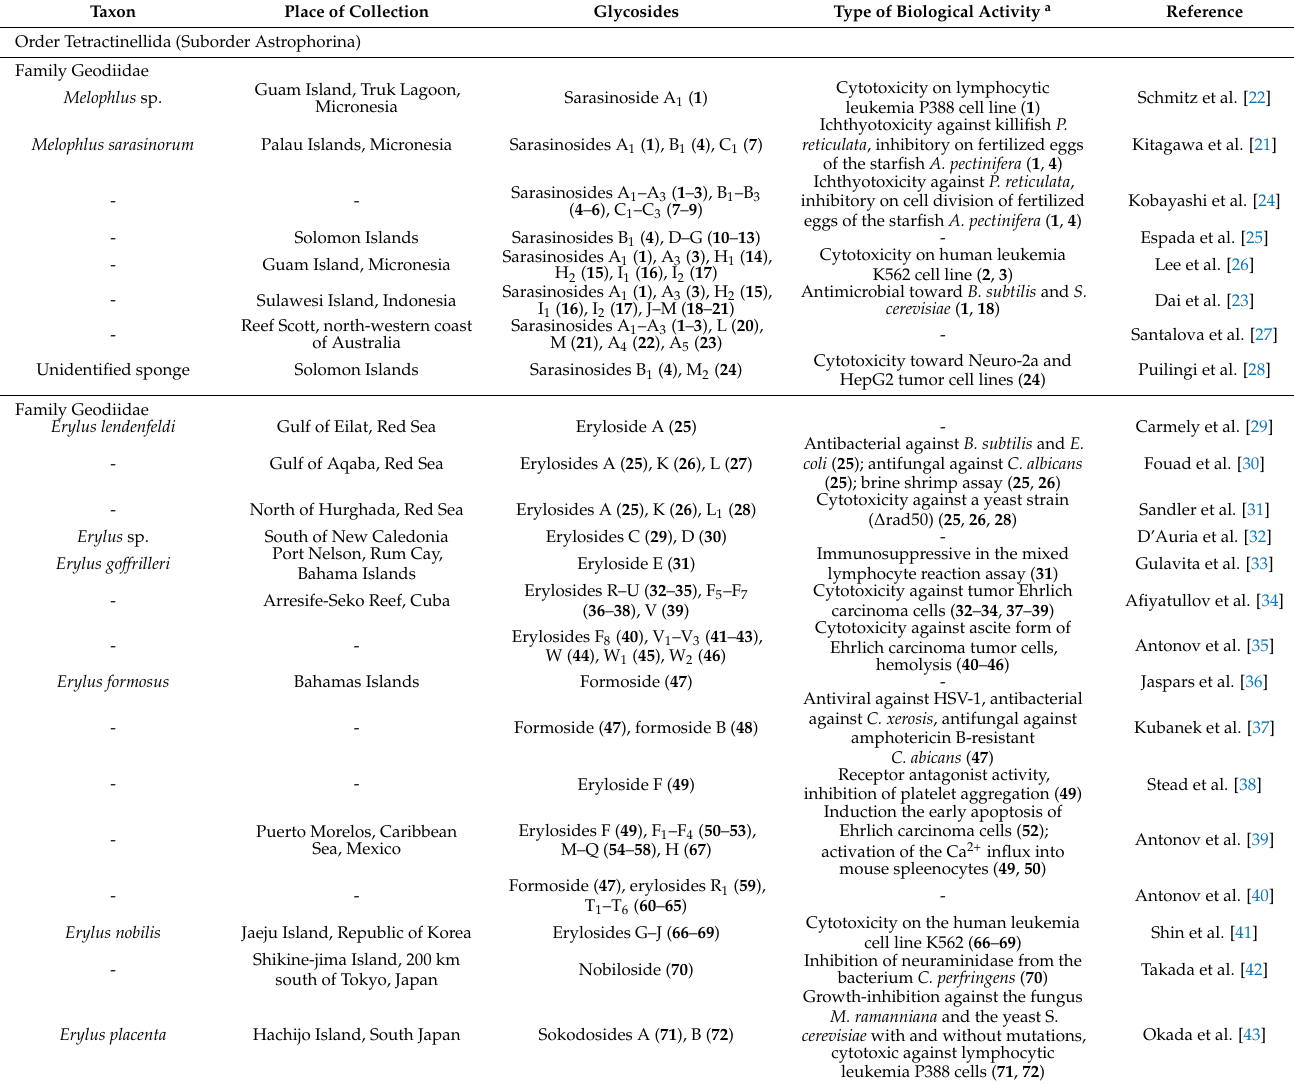
Table 1. Taxonomical distribution and biological activities of tetracyclic triterpene glycosides in sponges of the class